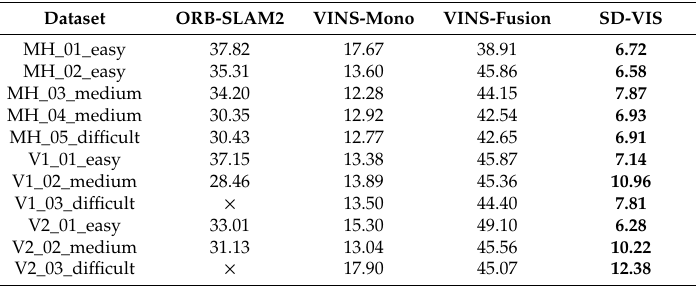
Table 2. Average time (ms) spent tracking an image.